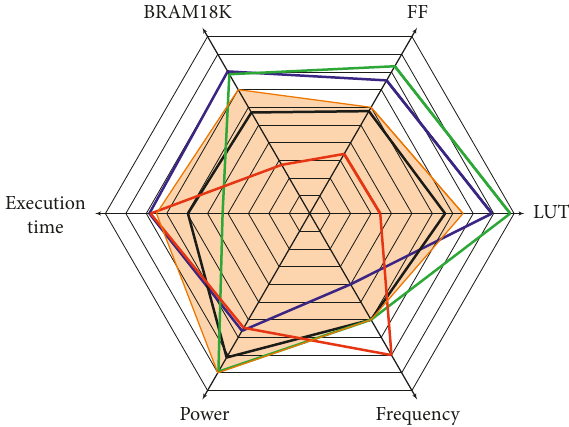
Figure 13: Radar chart for designs #7, #31, #42, #43, and system